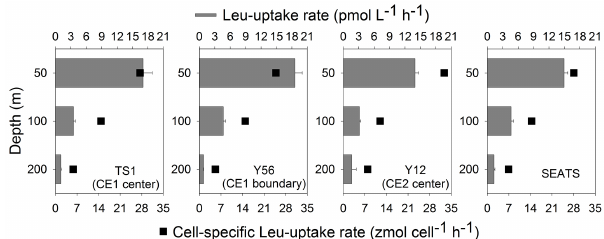
Fig. 5. Bulk leucine incorporation rates and cell-specific leucine in- corporation rates at representative depths in the eddy centers (TS1 and Y12), the eddy edge (Y56) and the reference site (St.